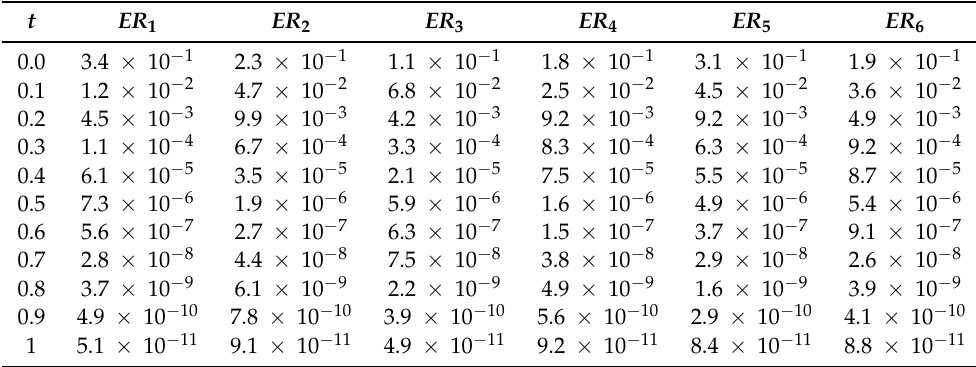
Table 4. The residual errors for ER 1 , ER 2 , ER 3 ER 4 , ER 5 and ER 6 for t ∈ ( 0,1 )